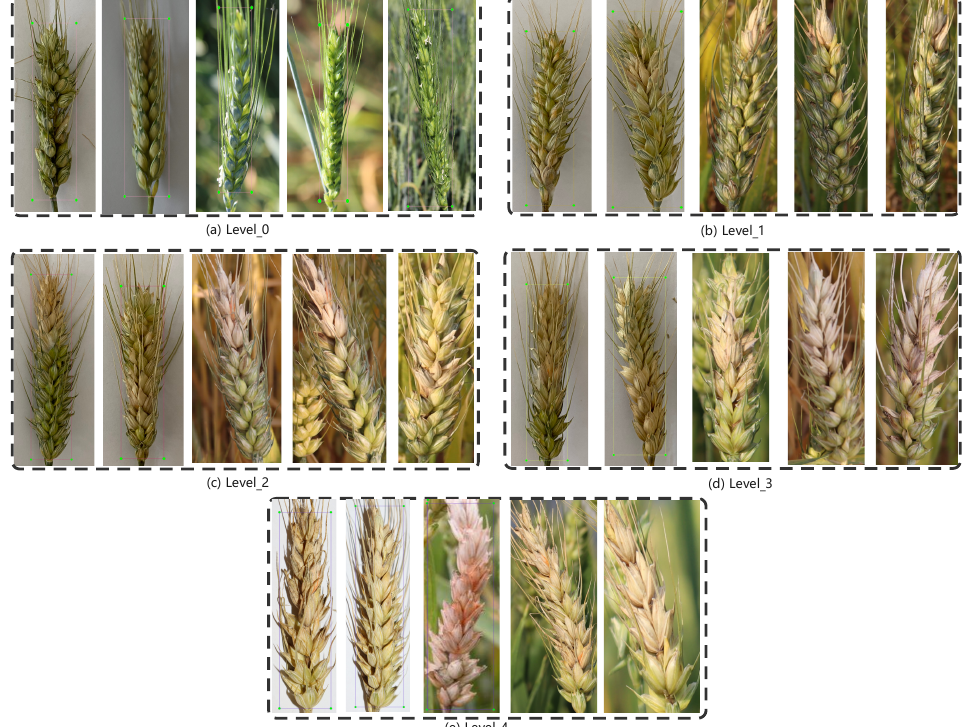
Figure 1. Wheat FHB with different severity levels under experimental and field conditions in the